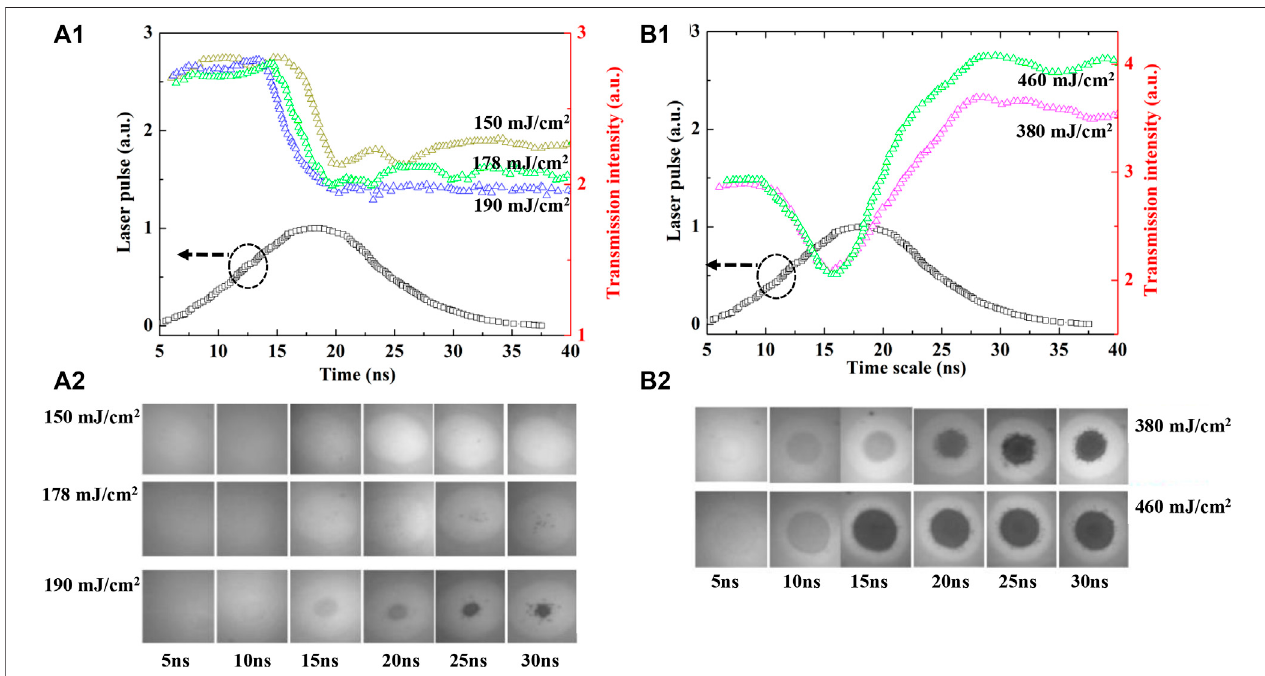
FIGURE6| Thetransmissionprobingcurveandtheircorrespondingtime-resolvedimageseriesofnslaser-induceddewettingandoxidationprocesswithdifferent laser fl uences: (a1, a2) 150 mJ/cm 2 , 178 mJ/cm 2 , 190 mJ/cm 2 , (b1, b2) 380 mJ/cm 2 , 460 mJ/cm 2 (Each frame is taken at a certain fl ash lamp delay time).